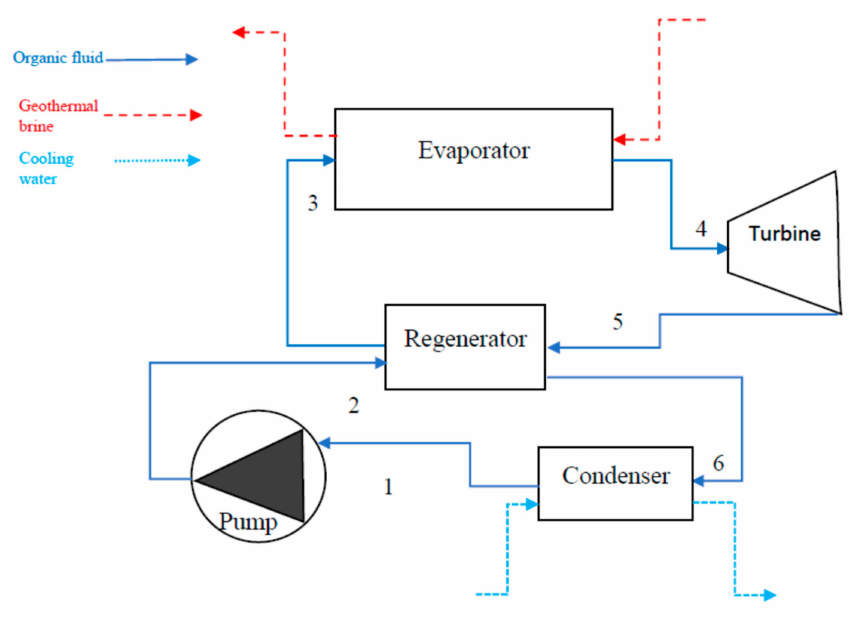
Figure 2. Organic Rankine Cycle (ORC) configuration. Table 2. Chemistry composition of geothermal fluid for low-medium temperature sources. Geothermal Fluid